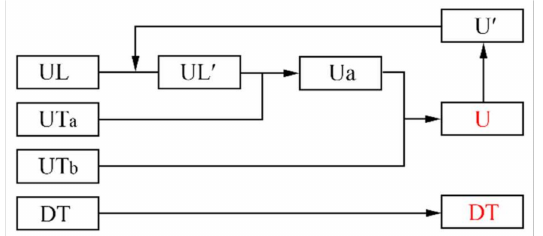
Figure 24. The schematic diagram of vortex evolution in U-DT